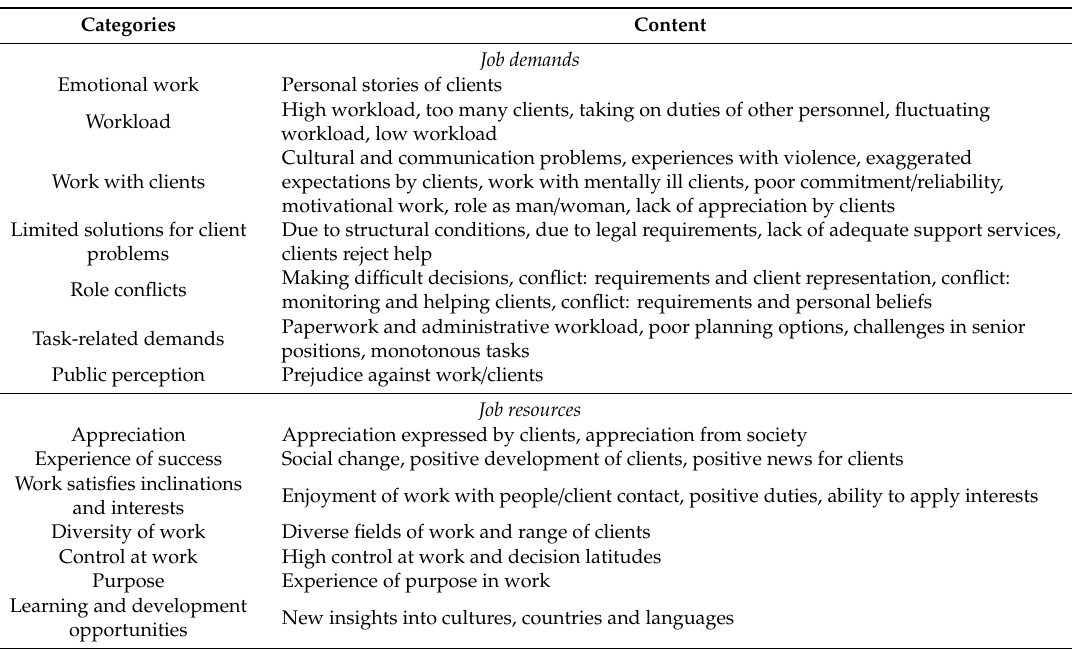
Table 2. Job demands and resources relating to the job